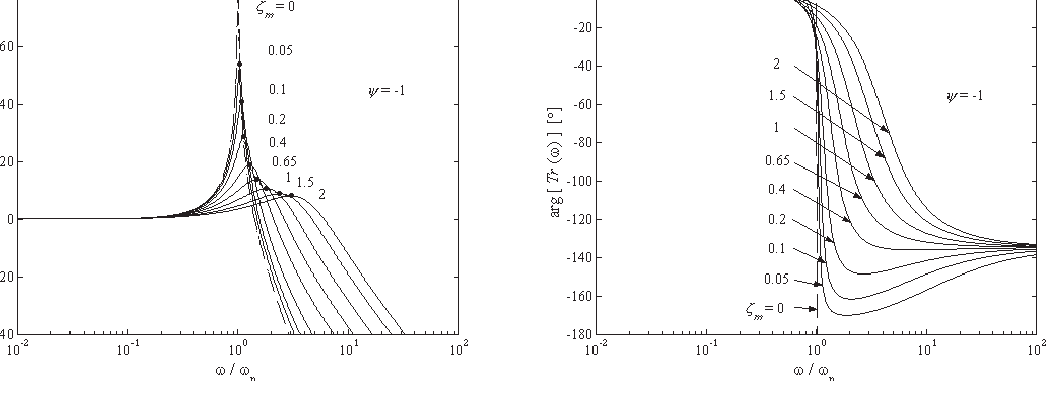
Fig. 16. Modulus (left) and phase (right) of TRF for ψ = − 1 .